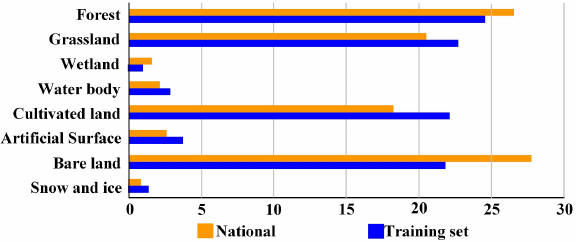
Figure 4. Proportions of different classes for China and on the training